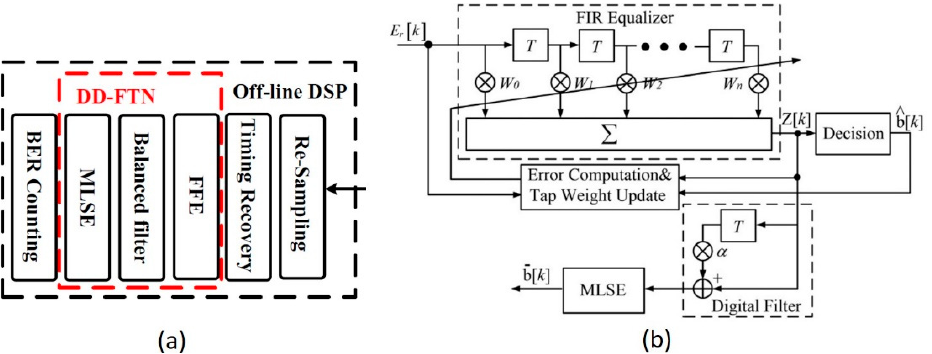
Figure 9. ( a ) The components and ( b ) the structure of DD-FTN (reprinted from [33] with permission from authors and reprinted from [7] with permission from IEEE).